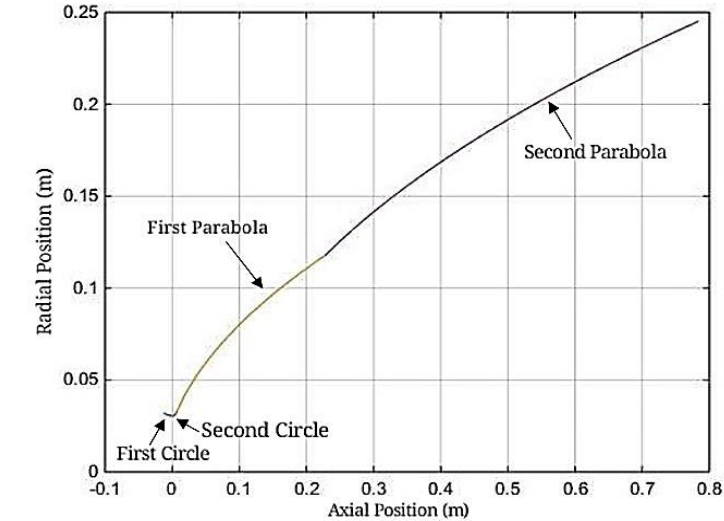
Figure 3: Dual bell nozzle with labeled section